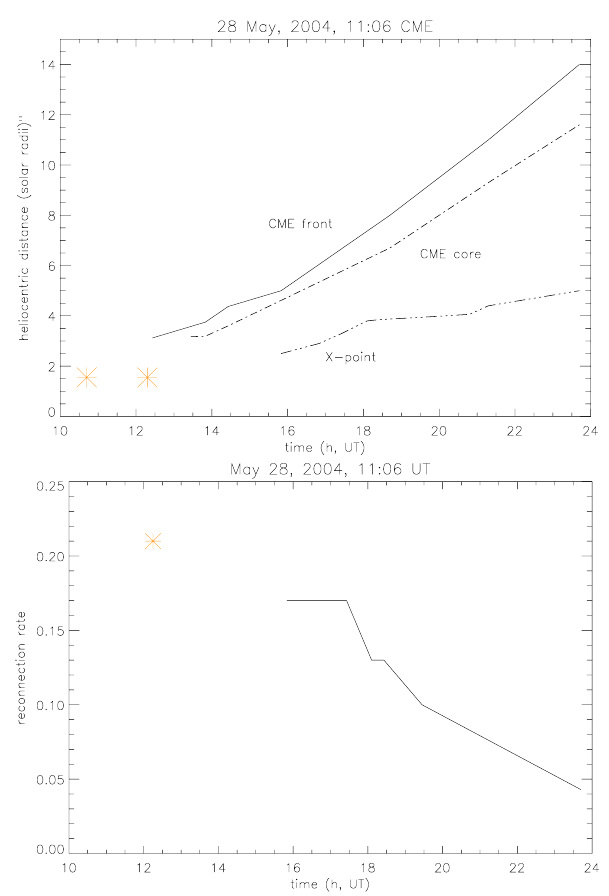
Fig. 6. Top panel: rise with time of the CME front and core (solid and dot-dashed line, respectively) and of the X-point; bottom panel: temporal profile of the reconnection rate from 1.55 to 5 R (cid:12) . The star symbols refer to data points derived from UVCS observations and show the times at which the CME front ( ≈ 10:40UT) and the X-point ( ≈ 12:20UT) reach the 1.55 R (cid:12) level where the UVCS slit was set. The data point have an uncertainty lower than a factor